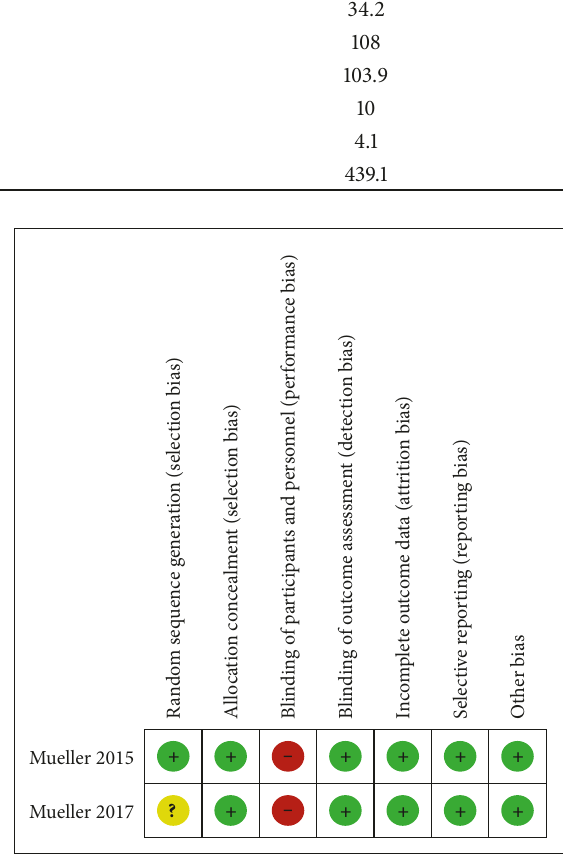
Figure 2: Quality appraisal. + (green), low risk of bias; ? (yellow), unclear risk of bias; − (red), high risk of